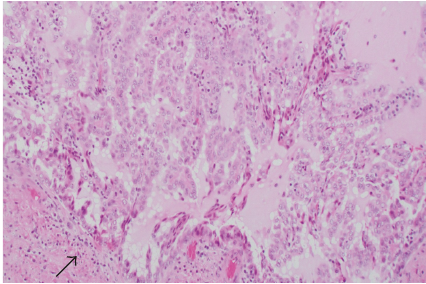
Figure 2: Tumor appears to be arising from the renal pelvis (arrow) and has a papillary, micropapillary, and tubular architecture (200x, H&E stain).